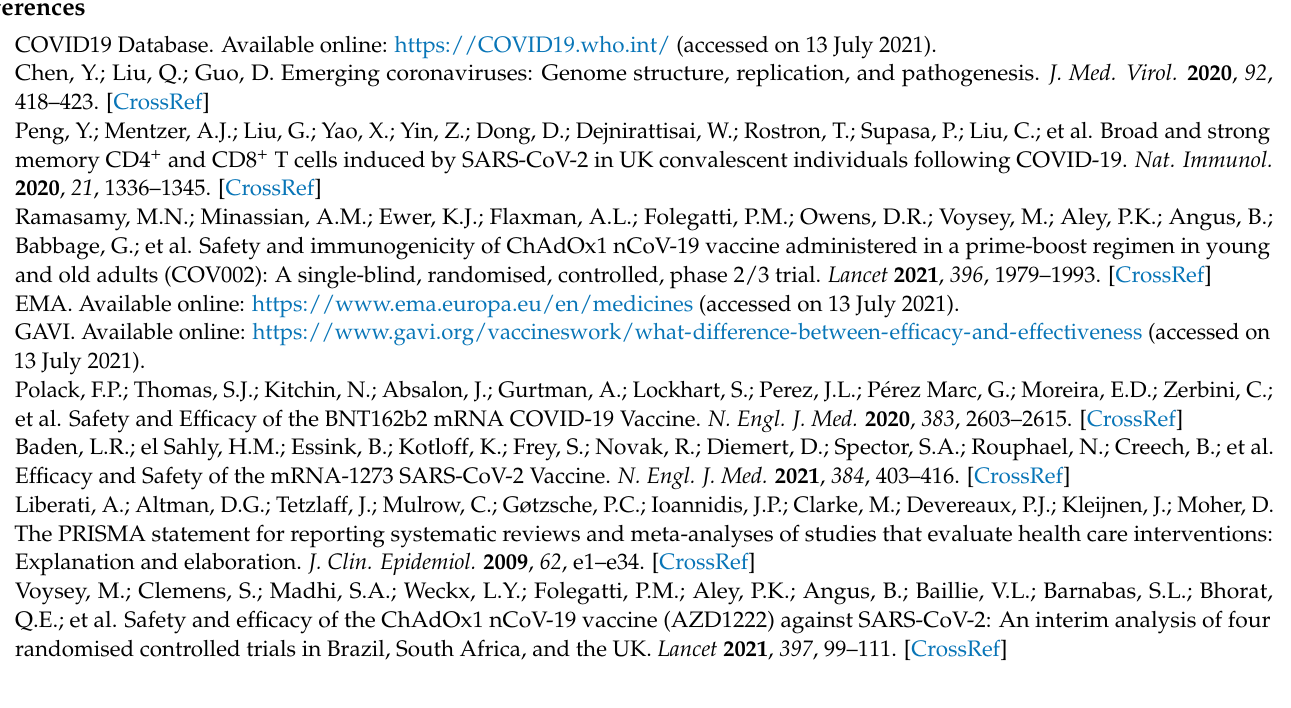
Table S8: Characteristics of 31 selected studies. Table S9: Quality assessment Newcastle–Ottawa Scale (NOS). Figure S21: Funnel plot and Eggers’ test. Figure S22: PRISMA Flow